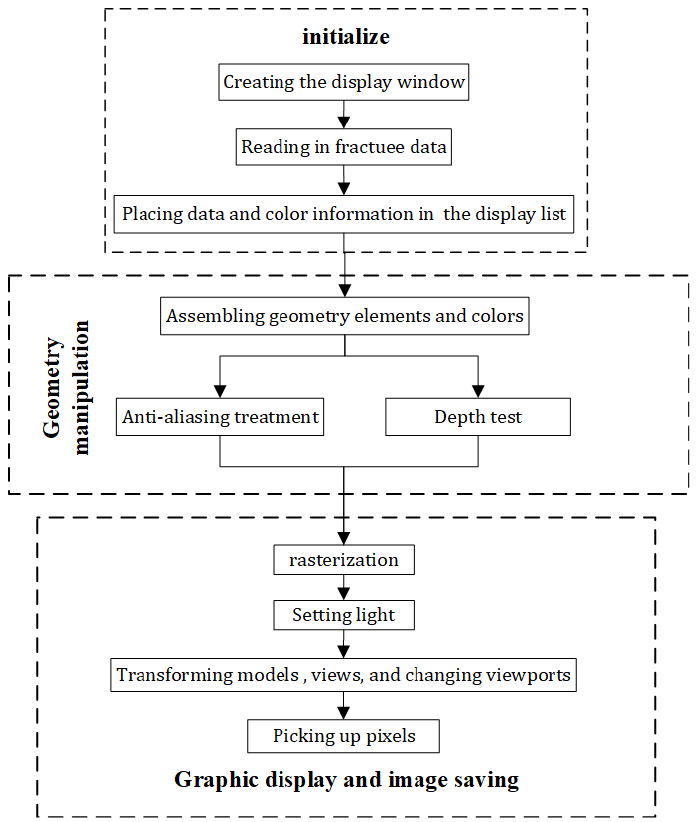
Figure 2. Visualization flow of DFN base on Open